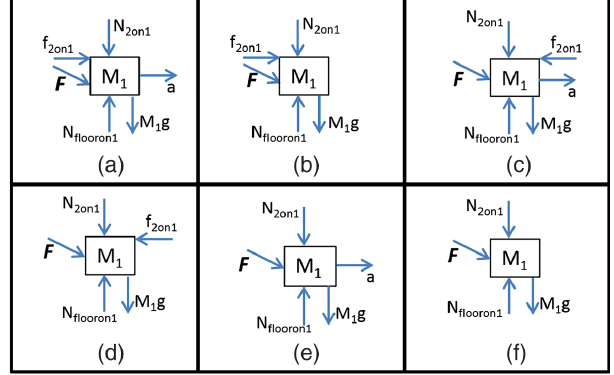
FIG. 13. Answer choices given for question 1 on version C of week 7, level 1 problems.